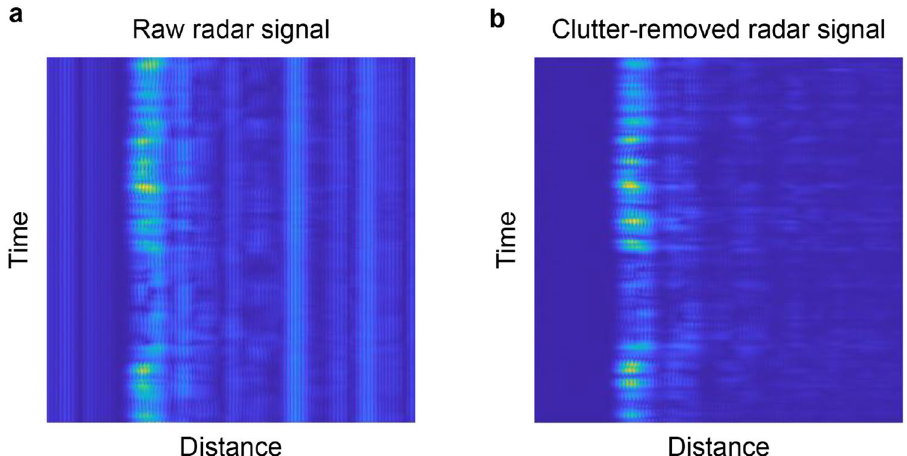
Figure 4. Background subtraction algorithm. ( a ) Signal before background subtraction. ( b ) Signal after background subtraction.